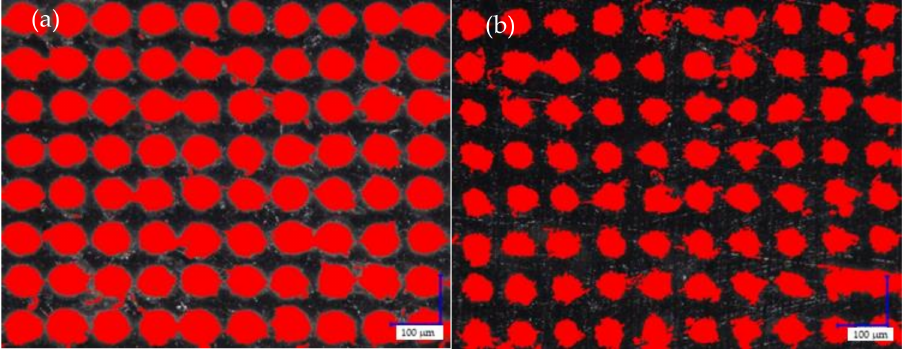
Figure 14. The degree of filling of the graphic fields with the interference of the laser beam, caused by thermal defects: ( a ) 0.7 wt% silica 1350 mm/s, 0.09 mm; ( b ) 7.7 wt% silica 1350 mm/s, 0.09 mm; magnification: 400 × ; dimensions of investigated images: 750 µ m × 1000 µ m, (Keyence